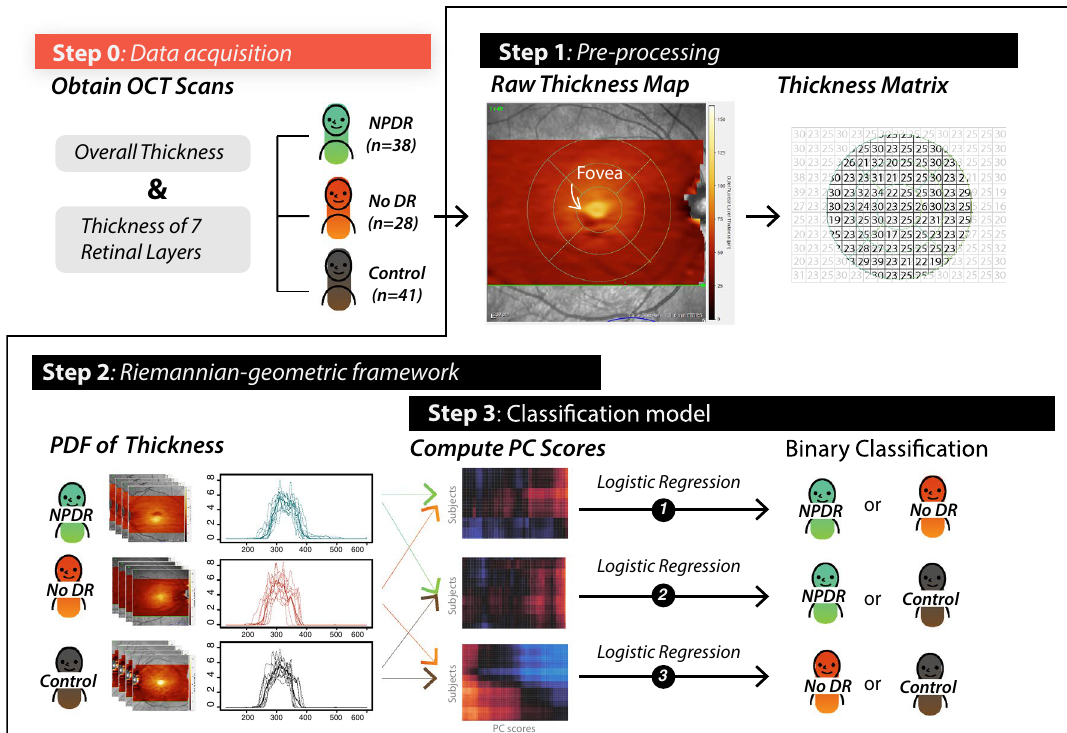
Figure 1. Overview of the analysis pipeline.